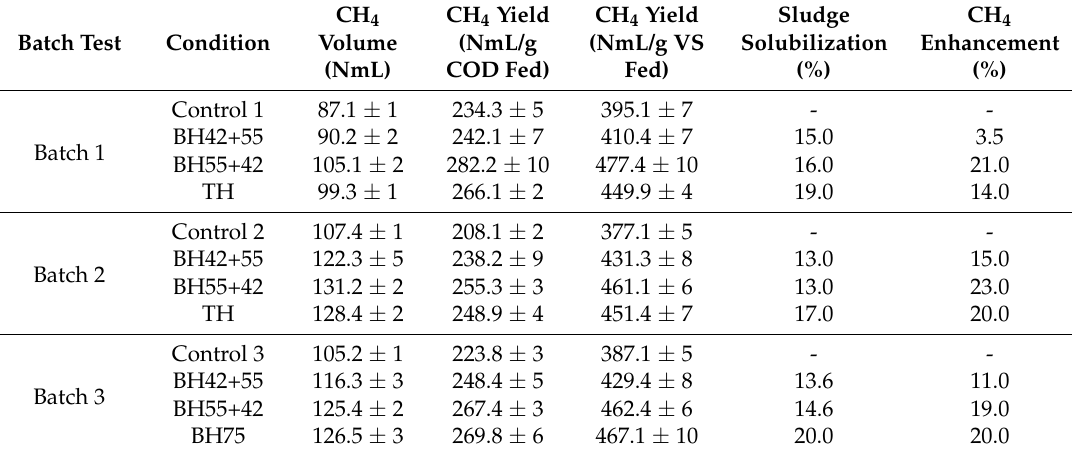
Table 3. Comparison of first, second, and third batches of the BMP